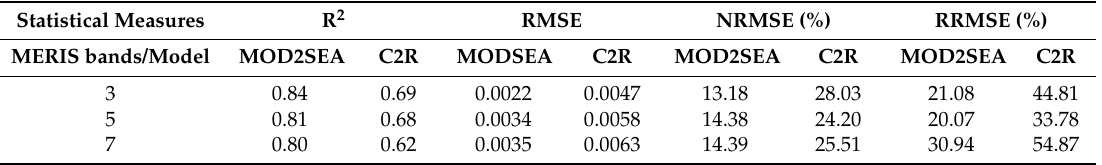
Table 4. Models’ performance evaluation in atmospheric correction part.